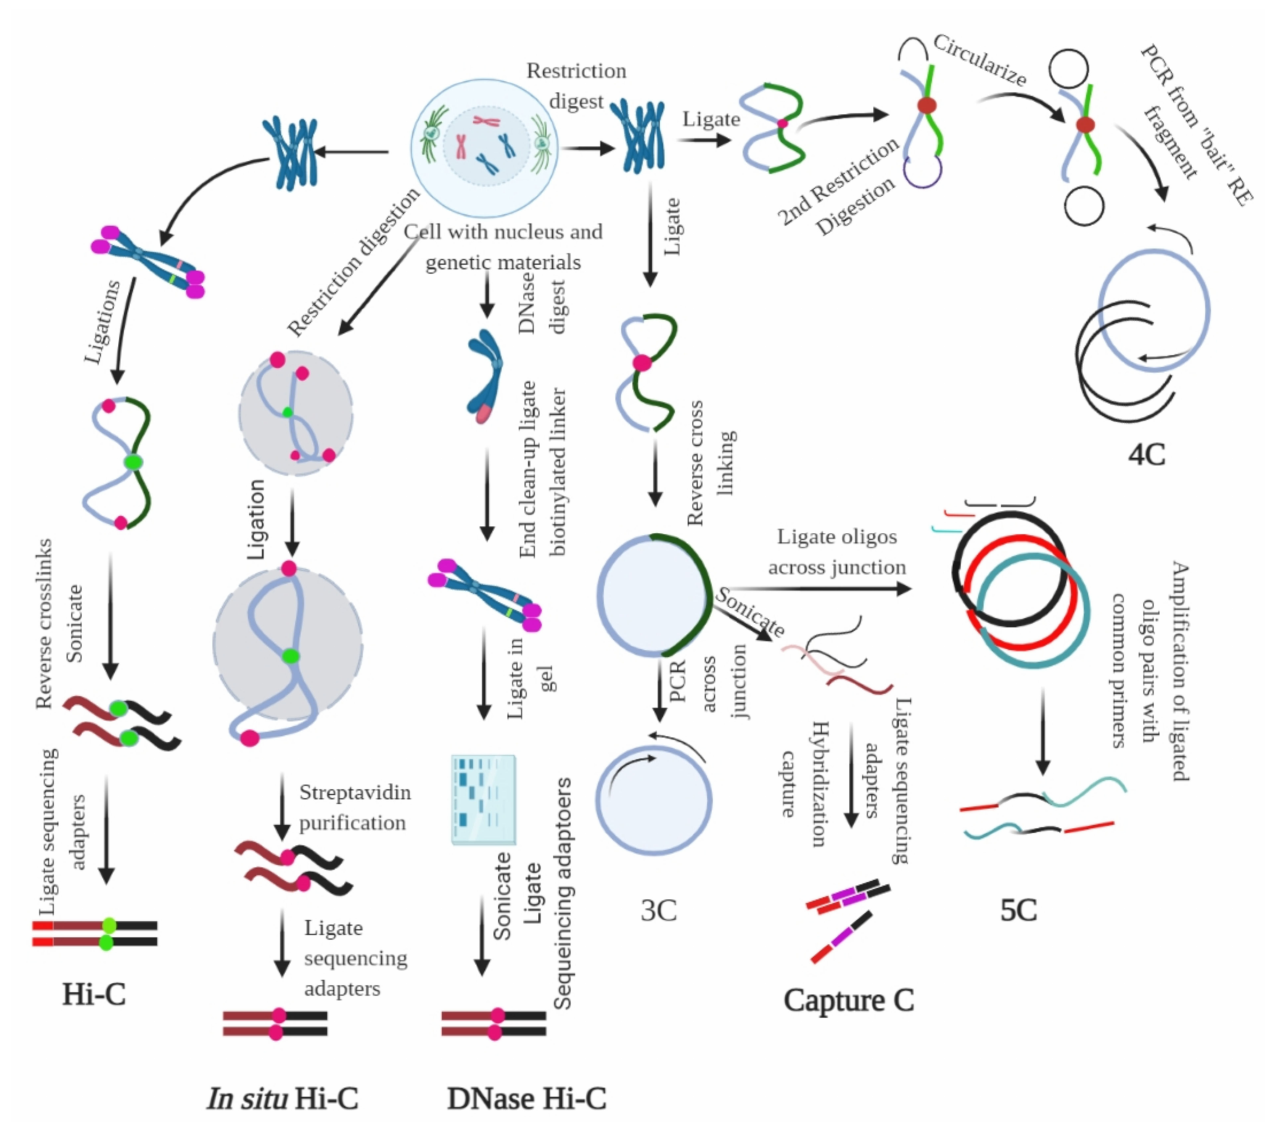
Figure 3. Chromosome conformation capture (3C) and its derivatives. It measures the contact frequencies of genomic loci by the proximity ligation of fragmented chromatin. All 3C procedures involve isolation of nuclei and DNA, followed by fixation of the chromatin. For Hi-C, ligation, followed by reverse cross-linking and addition of adaptors is required. For in situ Hi-C, streptavidin-based purification followed by the ligation of sequencing adaptors is required. For DNase Hi-C, the genetic materials are digested using DNase, followed by the ligation of biotinylated adaptor and adaptor-based sequencing. For 3C, restriction digestion is followed by ligation and reverse cross-linking and PCR across the junction. For capture C, reverse linking is followed by sonication, ligation of sequencing adaptors, and hybridization capture. In 5C, reverse cross-linking is followed by the ligation of oligos across the junction; the ligated oligo pairs are later amplified with a common primer. In 4C, restriction digestion and ligation are followed by the second step of restriction digestion, which circularize the genetic material; PCR is performed subsequently using the ‘bait’ RE fragment. The figure was prepared according to [18,79], with required